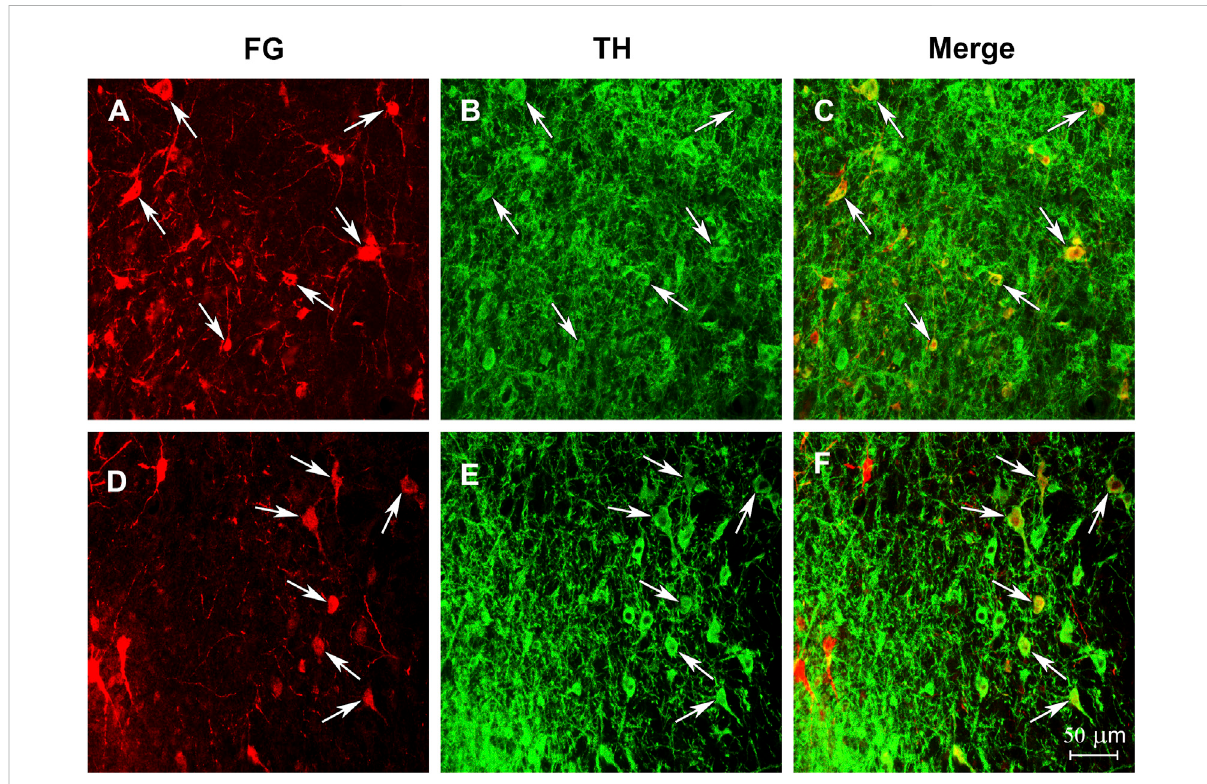
FIGURE 6 PhotomicrographsillustratethatthestarlingNACreceivesdopaminergicinputfromVTA.ConfocalimagesshowingimmunolabelingintheVTA from two birds (one bird per row) that received injections of the retrograde tract tracer Fluro-Gold into the NAC. (A and D) illustrate neurons labeled with tracer. (B and E) illustrate neurons labeled for TH. (C and F) illustrate neurons double labeled for both the tracer and TH. Arrows highlight the same double labeled cells in each image. Left is lateral for each